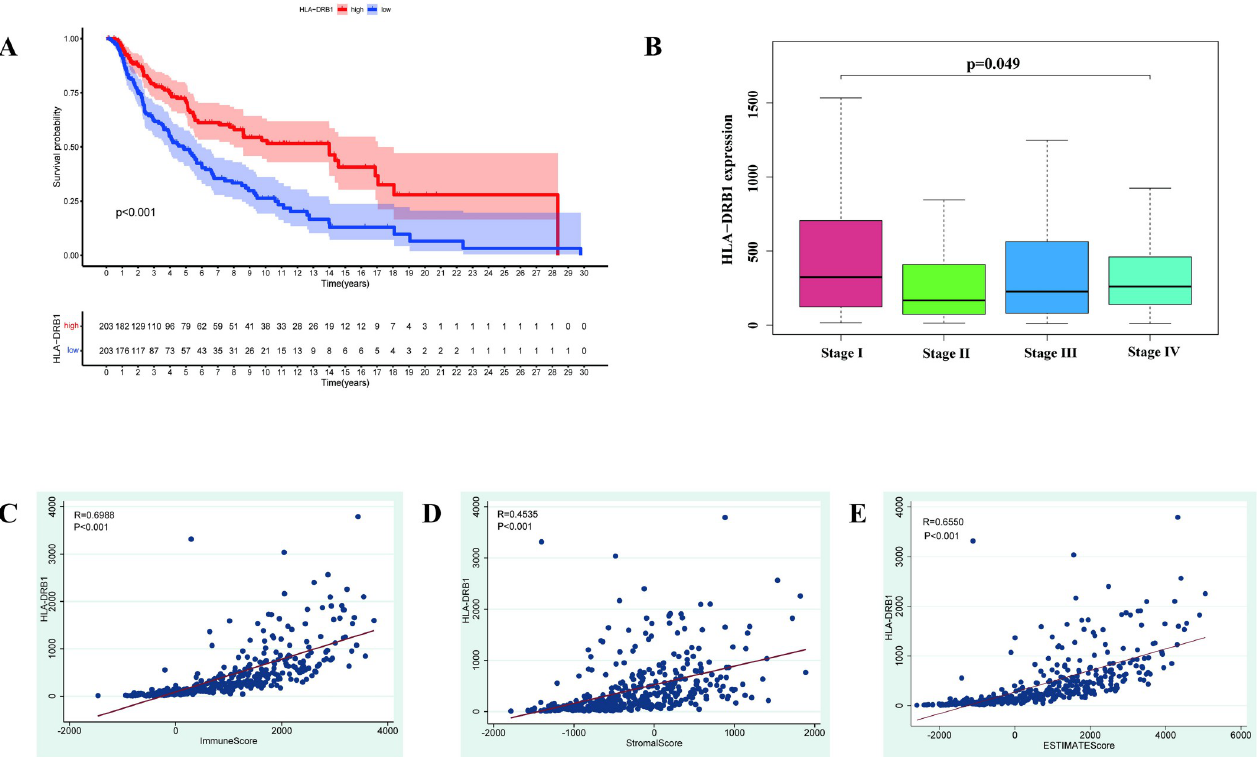
Fig 6. Survival analysis and correlation analysis of HLA-DRB1 expression. (A) The overall survival curve of the high HLA-DRB1 expression group and low HLA-DRB1 expression group. (B) The result of the correlation analysis between the expression level of HLA-DRB1 and the Stage of patients. (C-E) The results of the correlation analysis among the ImmnueScore, StromalScore, ESTIMATEScore, and the expression level of